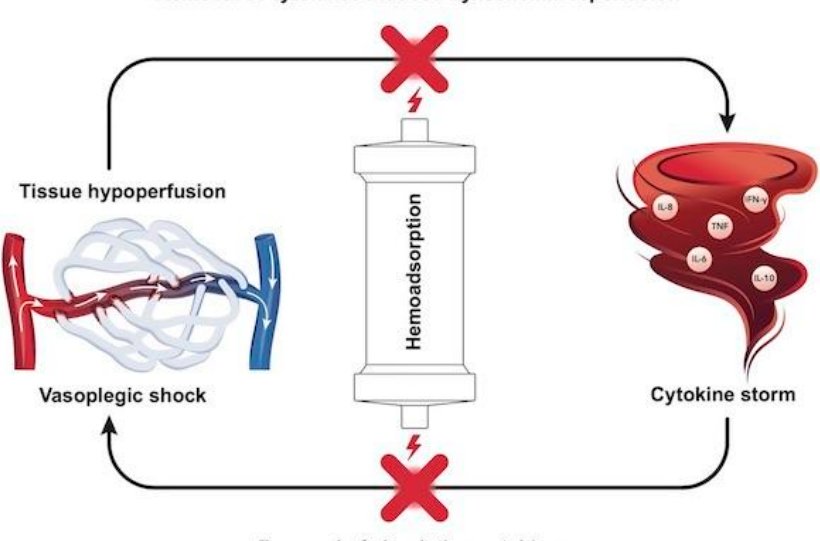
Figure 1. The vicious circle of hyperinflammation. Circulating cytokines can induce vasodilatation leading to arteriovenous shunting in the microcirculation and eventually vasoplegic shock. Hypoperfused tissues may further amplify the effects of cytokine storm byconcomittantly triggering an immune response, potentially leading to ischemia–reperfusion injury. Hemoadsorption can potentially attenuate this vicious circle and protect the tissues from this onslaught by removing circulating cytokines and those released after tissue injury.